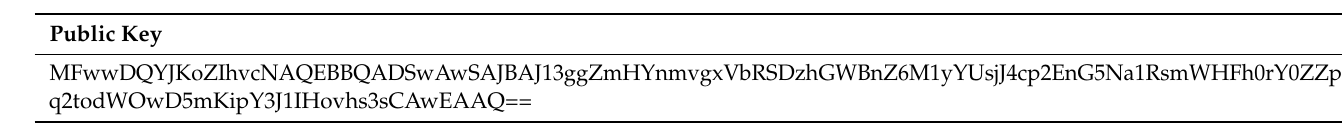
Table A6. Public key.